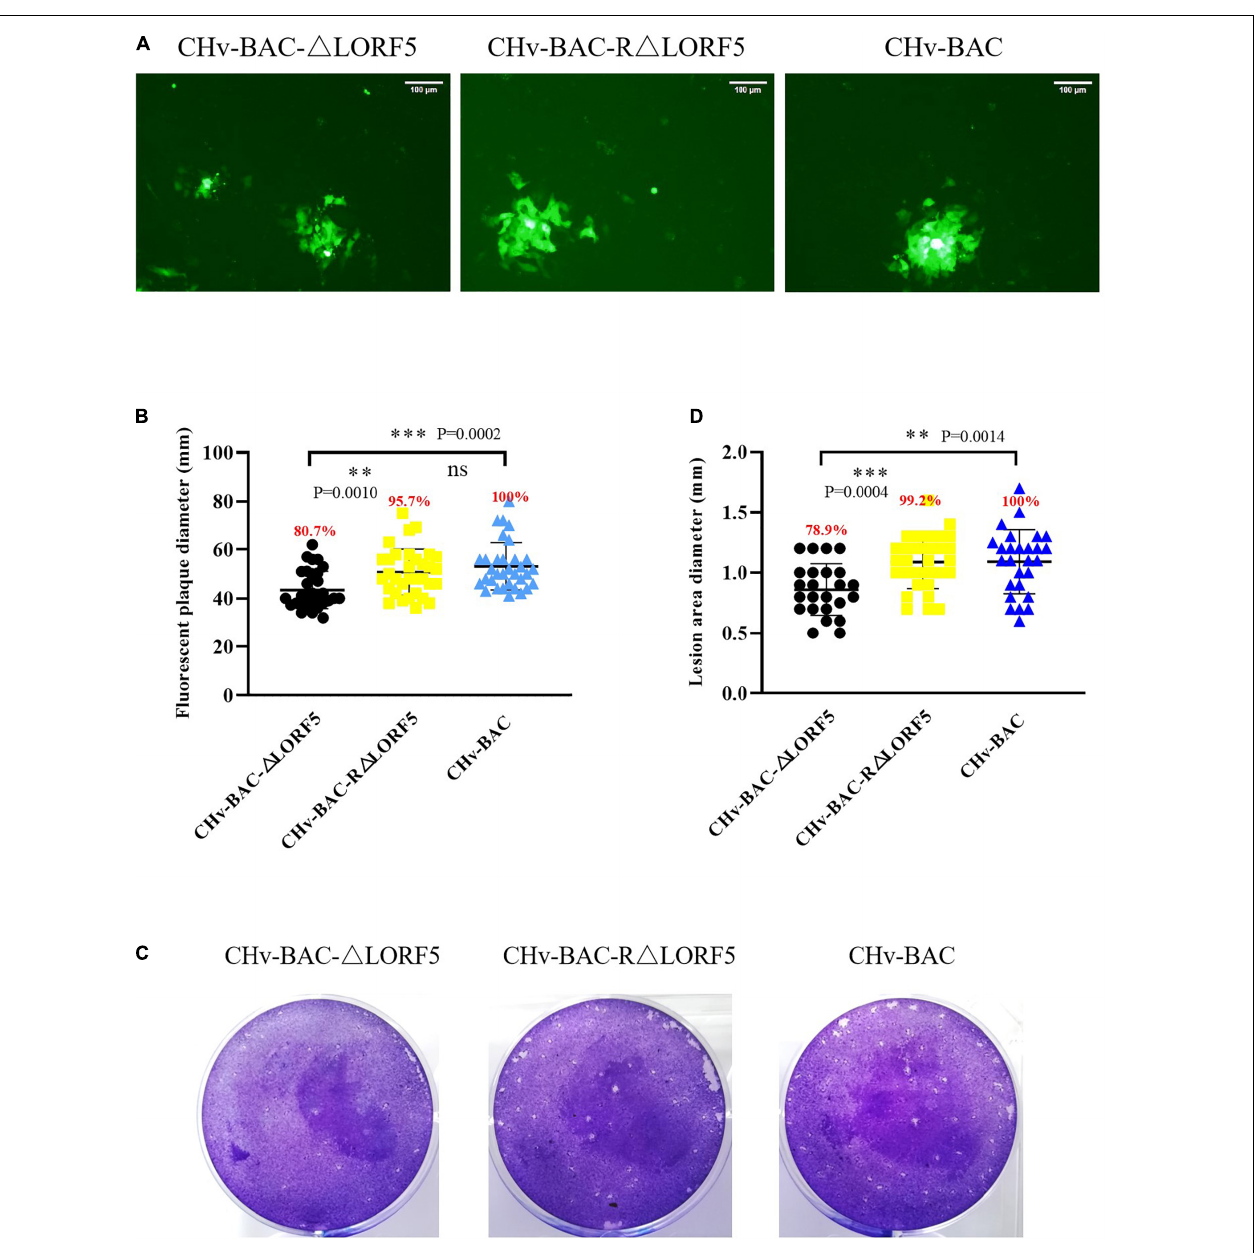
FIGURE 6 | Plaque size assays of indicated recombinant viruses. DEF cells in six-well plates were infected with 0.001 MOI of (cid:49) LORF5, R (cid:49) LORF5, or CHv-BAC. After incubation at 37 ◦ C for 2 h, the infected cells were covered with 1.5% methylcellulose and cultured in a 37 ◦ C, 5% CO 2 incubator. (A) Green fluorescent plaques produced by (cid:49) LORF5, R (cid:49) LORF5, and CHv-BAC. The cells were observed under a fluorescence microscope (Nikon TI-SR, Japan). (B) Statistical analysis of the data in panel (A) and shown as a scatter plot with minimum and maximum values (plaque diameters: mm). (C) Images of viral plaques after 0.5% crystal violet staining. (D) Statistical analysis of the data in panel (C) and shown as a scatter plot with minimum and maximum values. All data have been carried out in three independent experiments. The plaque size of the deletion virus and the reverted virus was compared with that of the parental virus (WT, CHv-BAC) set to 100%. Asterisks indicate significant differences compared to WT virus ( ∗∗∗ P < 0.001; ∗∗ P < 0.01; n > 50). The means and standard deviations were measured with GraphPad Prism 8. Standard deviations are shown by error